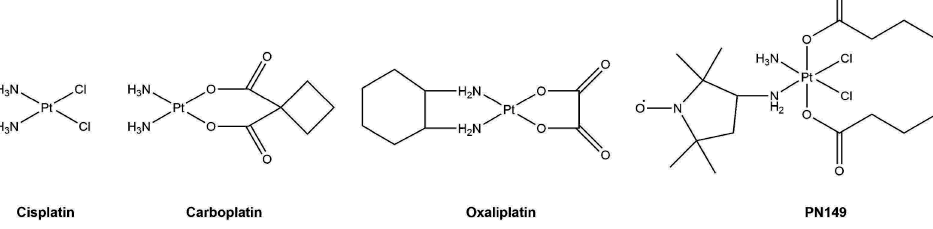
Figure 1. Structure of the platinum compounds cisplatin, carboplatin, oxaliplatin and PN149.